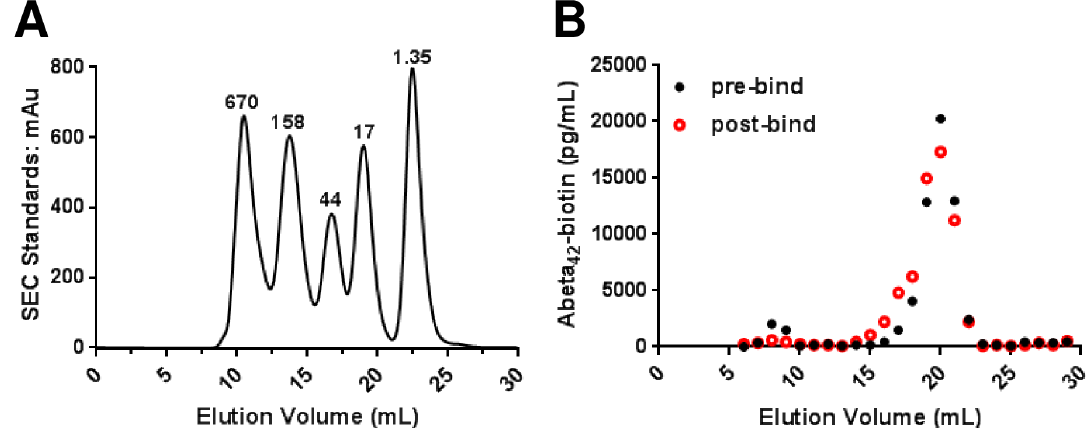
Fig 5. Size exclusion chromatography reveals that the A β 1-42 -biotin monomer remained predominantly low molecular weight during the experiment. ( A ) Globular protein molecular weight standards as run on a size exclusion Superdex 200 10/300 GL column. mAu = milli-absorbance units, kDa = kilodaltons. ( B ) The predominance of the pre-incubation (black closed circles) A β 1-42 -biotin elutes as a low molecular weight peak in fractions 18 to 21 likely corresponding to monomer, and a minority of the A β 1-42 -biotin eluted as a high molecular weight peak in fractions 8 and 9 corresponding to aggregated A β . The post overnight incubation sample (red open circles) has a minor shift to include a shoulder of fractions 16 and 17 in the low molecular weight peak suggesting the accumulation of oligomeric species while most the sample remained